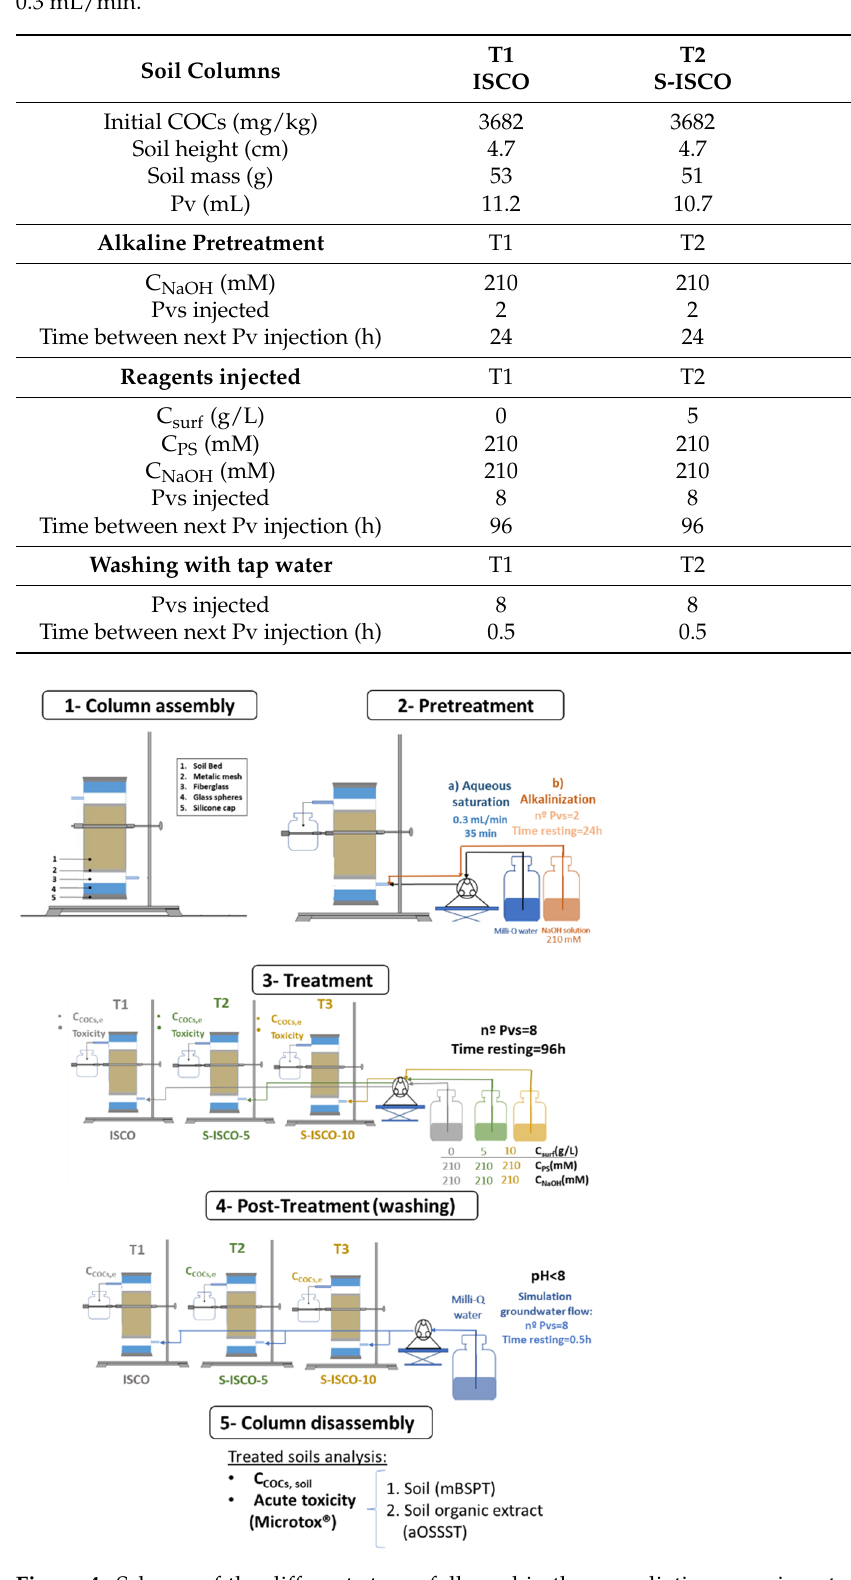
Figure 4. Scheme of the different stages followed in the remediation experiments. Experimental con- ditions are summarized in Table